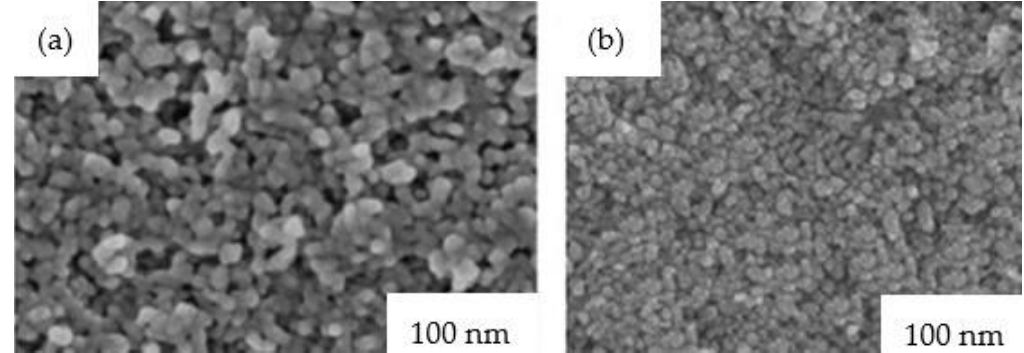
Figure 31. FE-SEM micrographs for nc-TiO 2 nanoparticles film: ( a ) before deposition; ( b ) deposited on H 2 W 2 O 11 electrolyte surface.